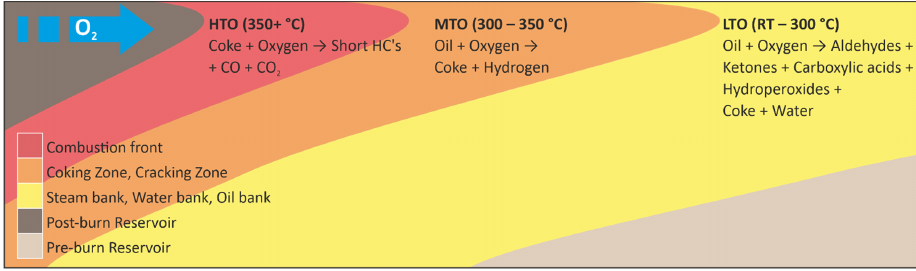
Figure 3. Schematic diagram showing the reaction zones across the reservoir between the post and pre-burn zones. The low temperature oxidation (LTO) reactions occur furthest from the combustion front between the reservoir temperature and 300 °C, medium temperature oxidation (MTO), or fuel deposition (FD) occurs between 300 and 350 °C and at the combustion front the fuel is burnt during high temperature oxidation (HTO), resulting in temperatures in excess of 350 °C [3,83].